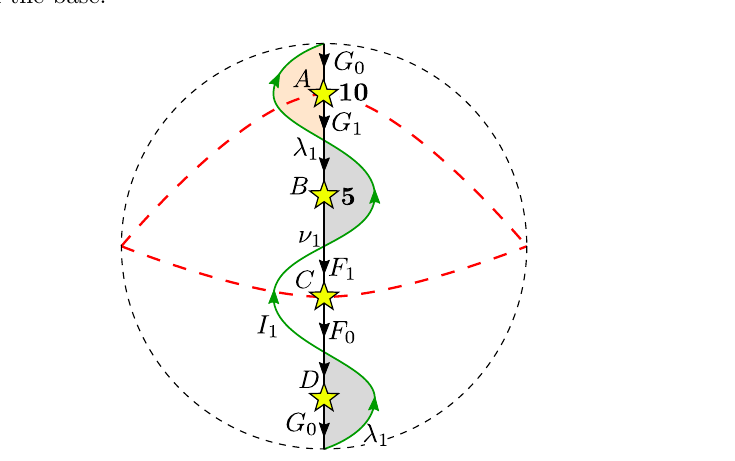
Figure 5 . Mirror for the conifold, as a (cid:12)bration over C , parameterized by a coordinate W . The generic (cid:12)ber is C (cid:3) times P 1 punctured at four points. The C (cid:3) (cid:12)ber degenerates at W = 0, and the punctured P 1 at W w 0 ; w 1 . The mirror of the fractional branes on the conifold wrap the 2 f g three-spheres S 3 and S 3 , obtained by (cid:12)bering the product of the degenerating 1-cycles in the (cid:12)ber 0 1 over the segment in the base.